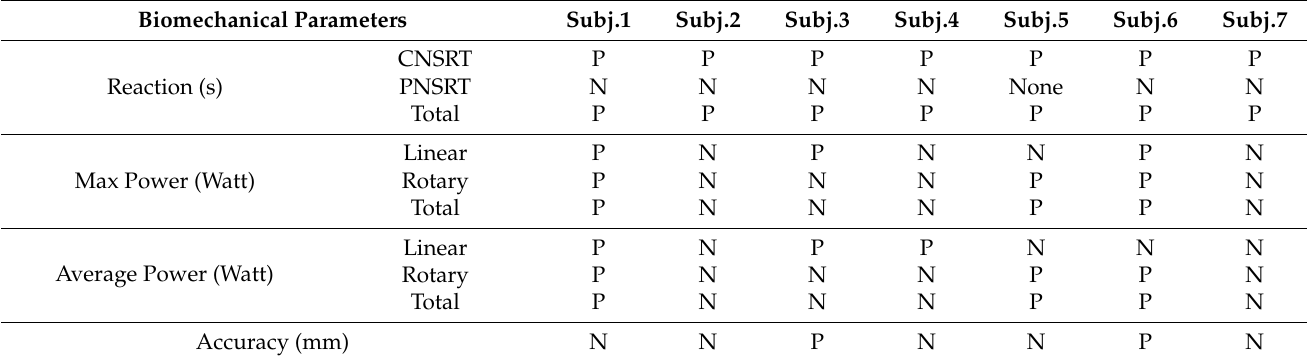
Table 3. The influences of weight cutting on individual